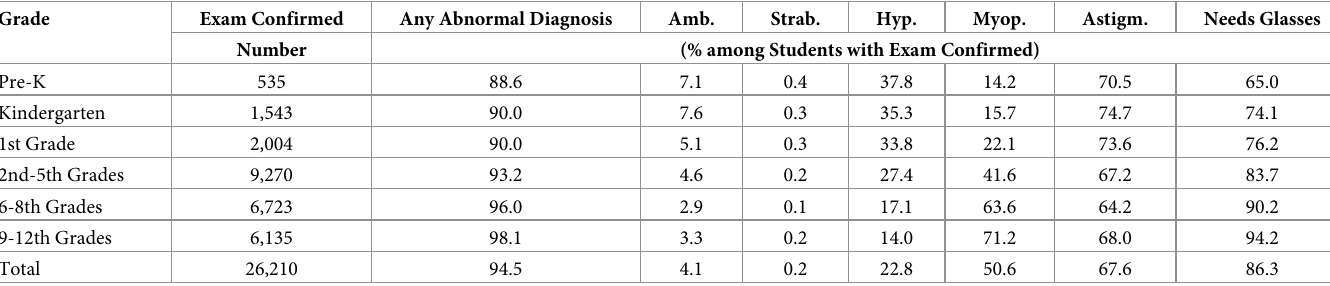
Table 7. Rates of abnormal diagnoses among screened students with confirmed exams in community schools by grade, 2018–19. Grade Exam Confirmed